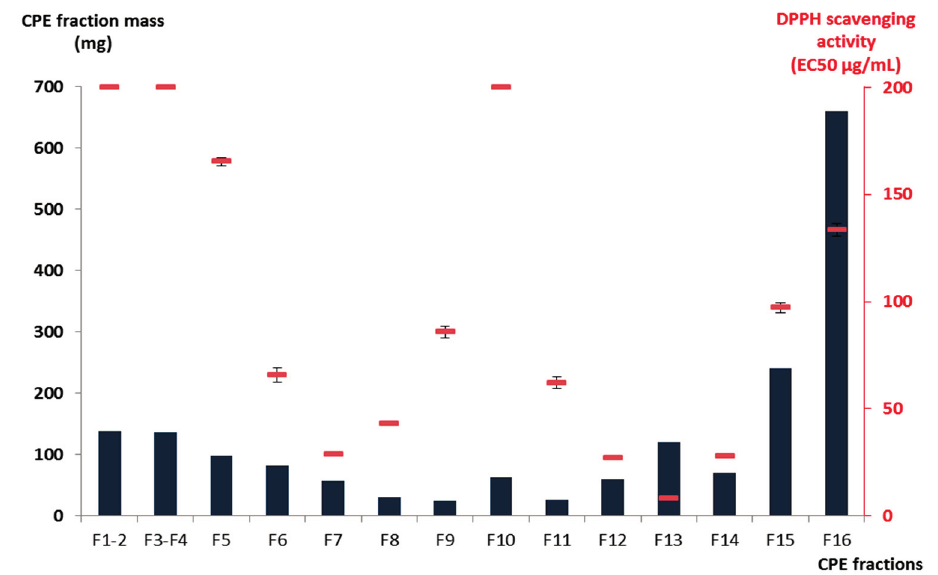
Figure 1. Mass and DPPH radical scavenging activity of the CPE fractions